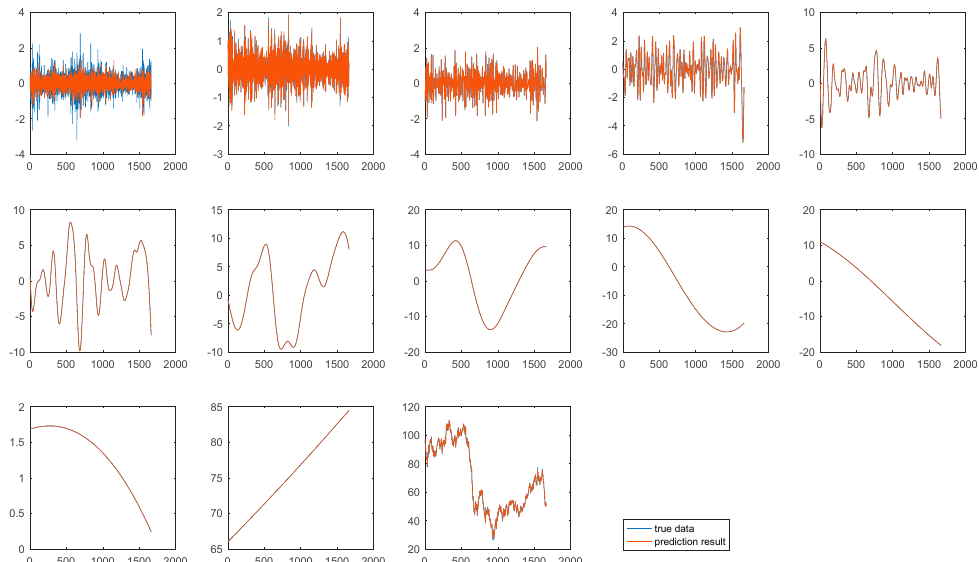
Figure 7. Prediction result of each component in one-step-ahead forecasting on WTI crude oil prices.